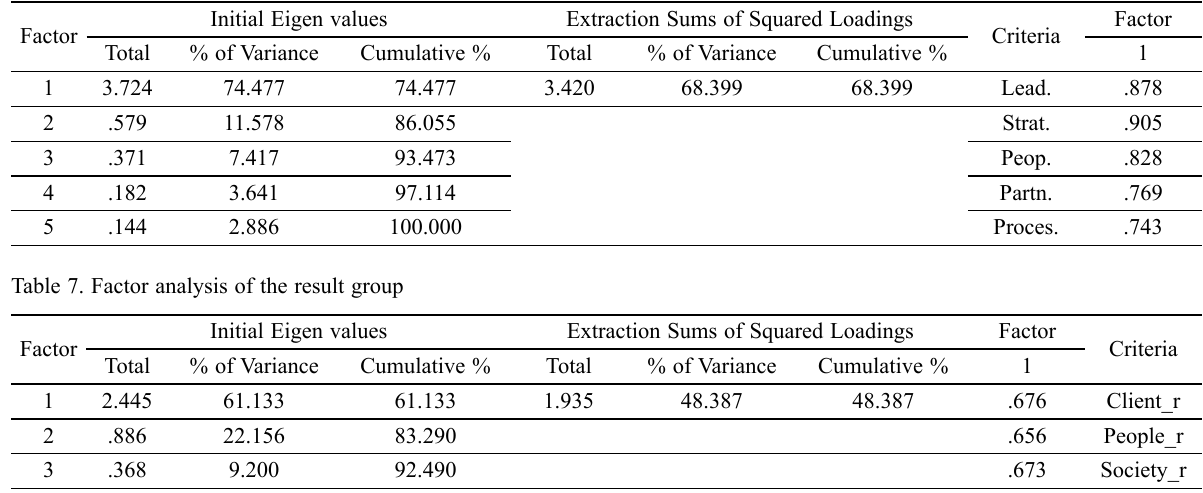
Table 6. Factor analysis of the enabler group Initial Eigen values Extraction Sums of Squared Loadings Factor